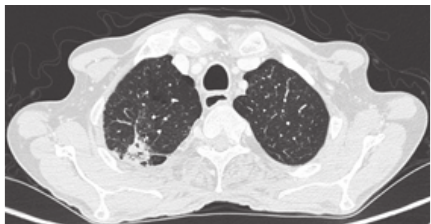
Figure 1: Fibrotic changes with focal pleural thickening in right apex with associated paraseptal emphysema suggestive of old healed